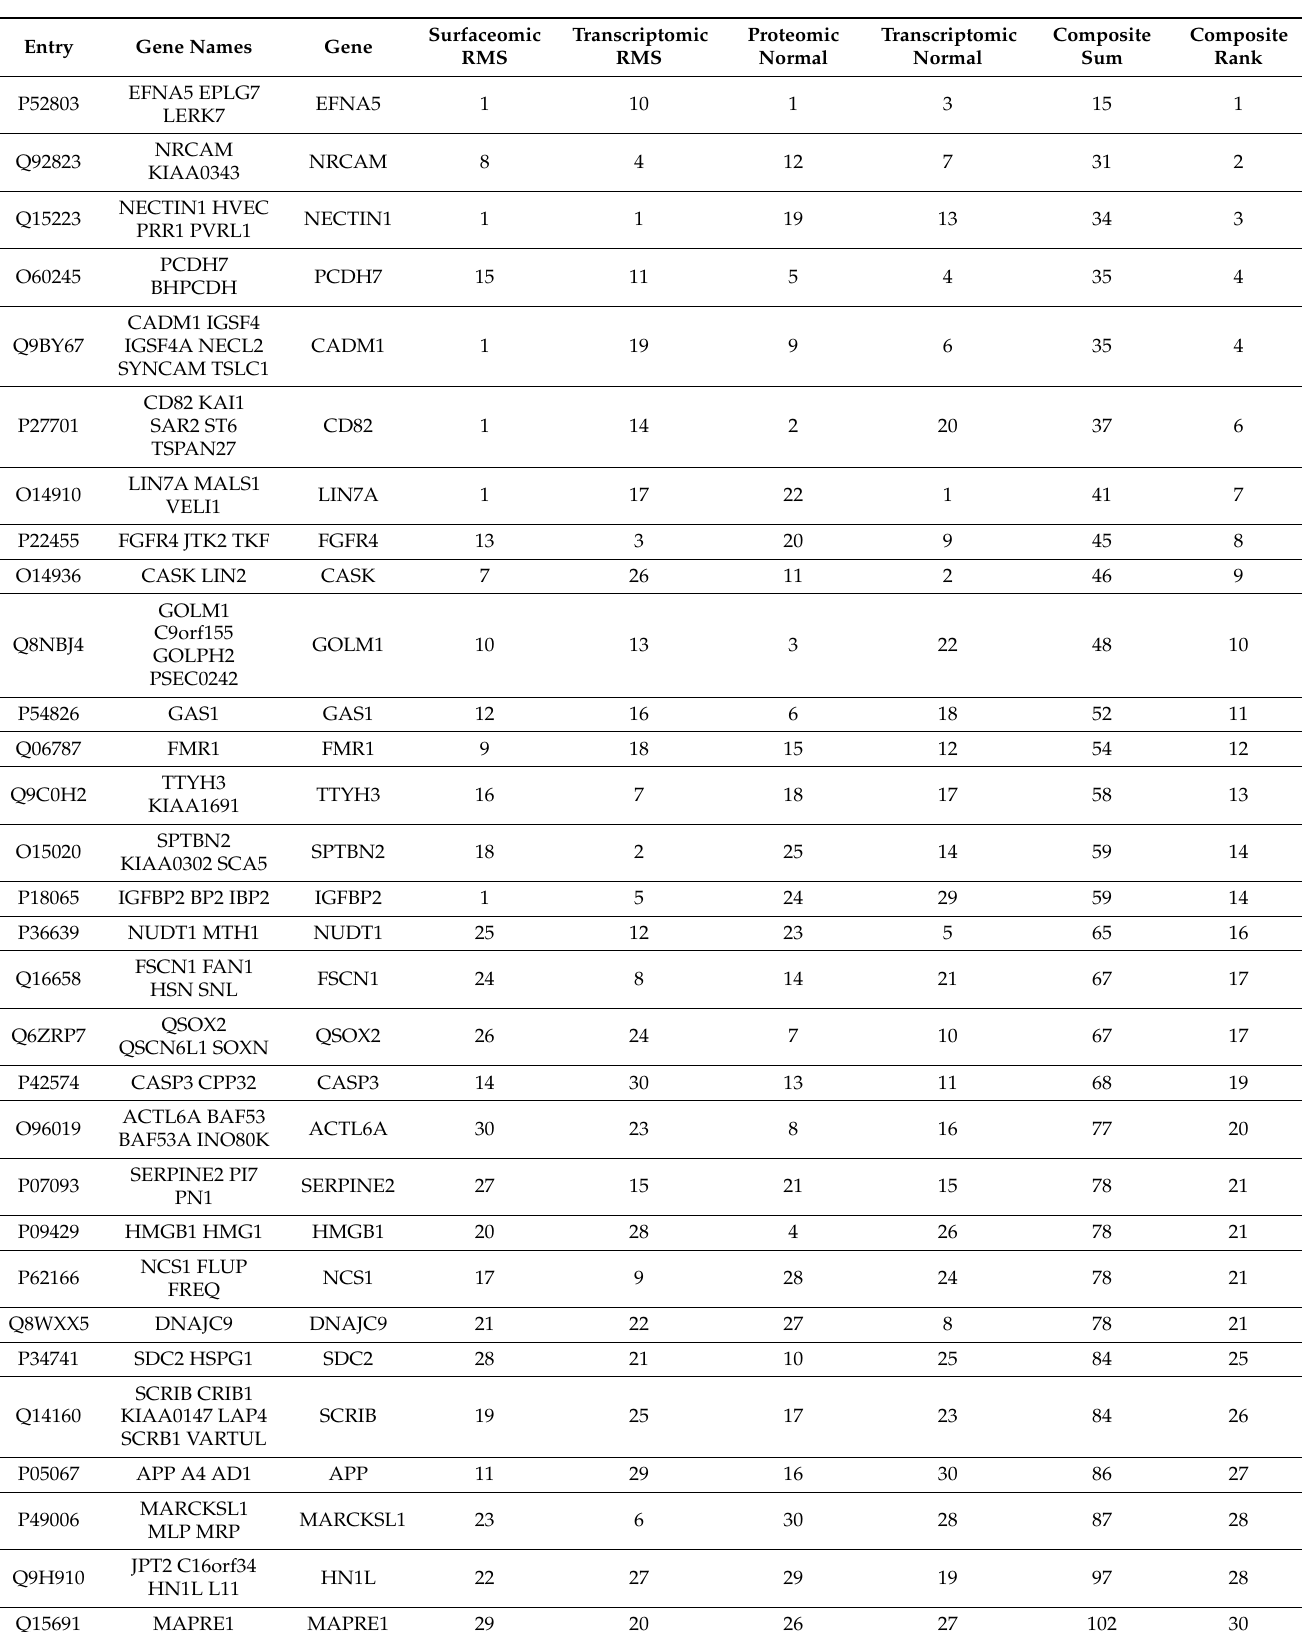
Table 2. Composite ranking of fusion-negative RMS-enriched cell-surface proteins based on combined transcriptomic and proteomic